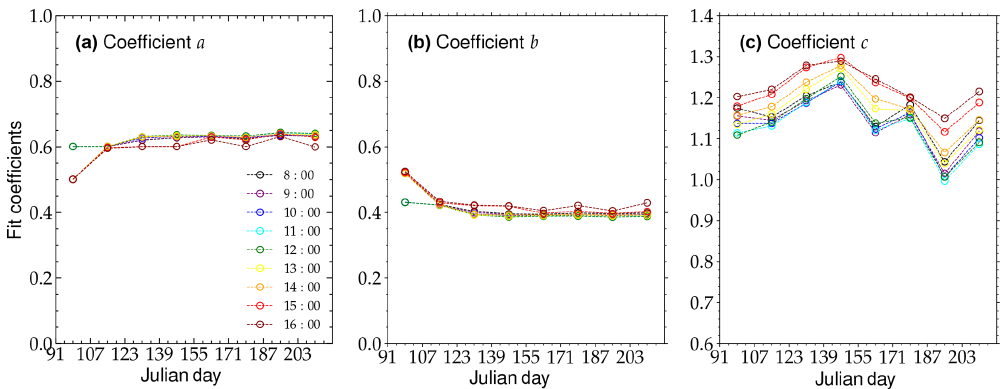
Figure 2. (a) Fit coefficients a , which are used to derive higher-resolution SEVIRI reflectances by means of statistical downscaling, as a function of Julian day. Coefficients are derived hourly and in 16d intervals for the Germany domain between 1 April and 31 July 2013. Colors illustrate different UTC times. (b) Same as (a) but for fit coefficients b . (c) Same as (a) but for fit coefficients c .